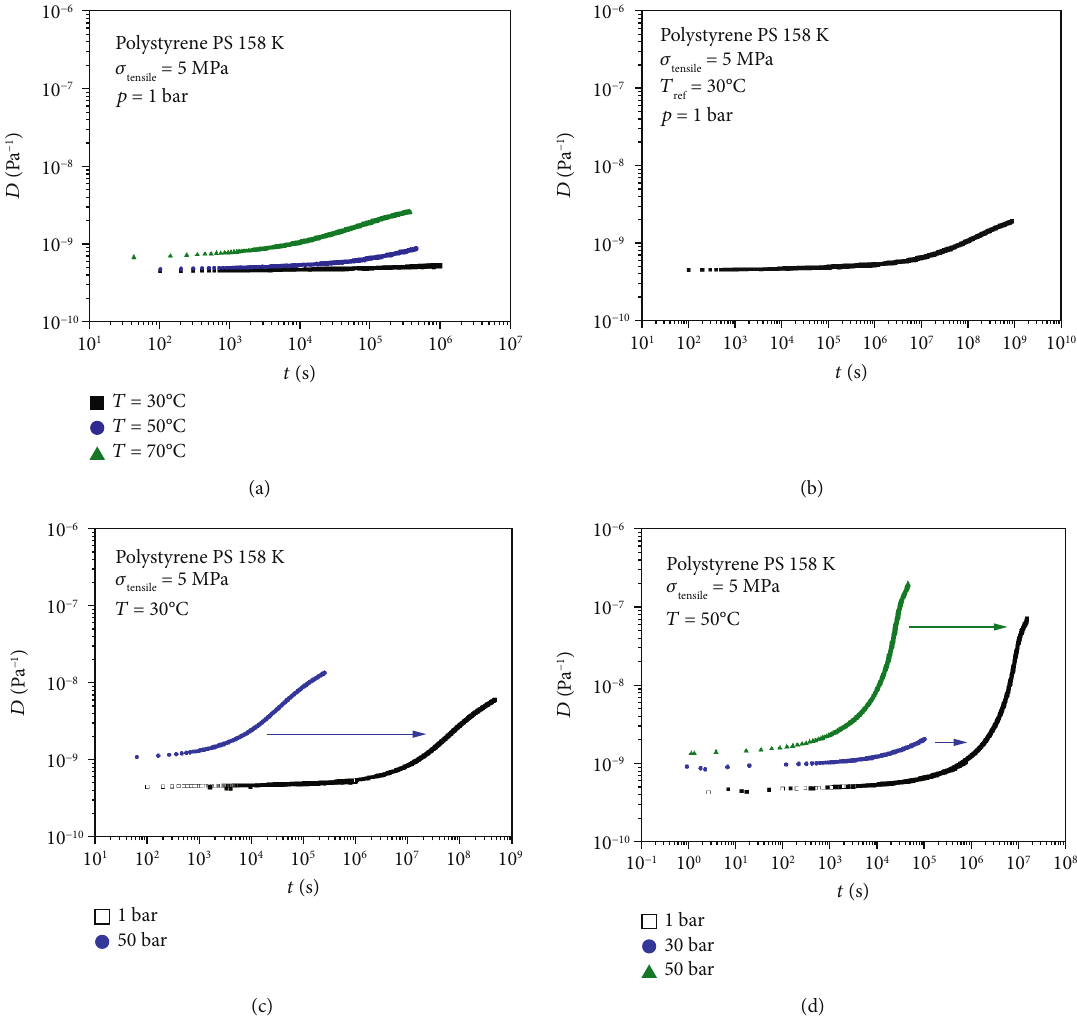
Figure 9: Time-dependent tensile creep compliance D ð t Þ of polystyrene PS 158K at various temperatures and pressures. (a) Tensile creep compliance at a pressure of 1bar and temperatures of 30, 50, and 70 ° C. (b) Mastercurve of the data in (a). (c) Creep compliance at a temperature of 30 ° C and pressures of 1 and 50 bar as well as the mastercurve for a pressure of 1bar. (d) Creep compliance at a temperature of 50 ° C and pressures of 1, 30, and 50 bar as well as the mastercurve for a pressure of 1bar. In (c) and (d), the data of the mastercurves appear in black